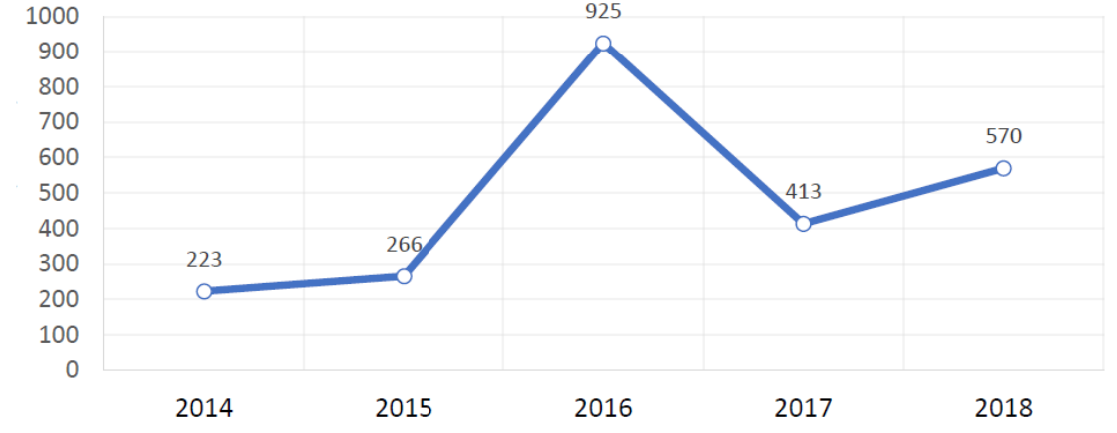
Figure 11: Earnings before taxes of EUROVIA CS (CZK million), (source: Annual report of EUROVIA CS 2014- 2018, data processed by the